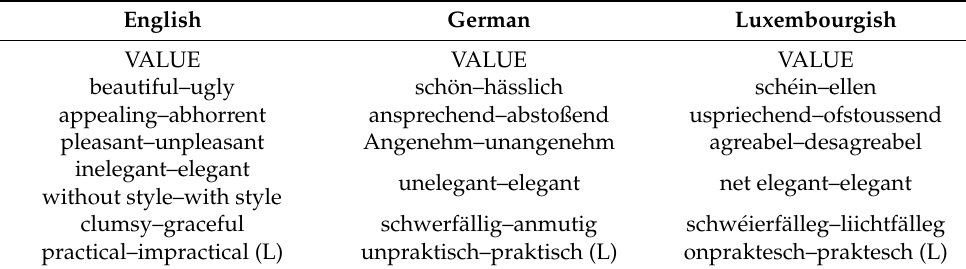
Table 1. Bipolar adjective pairs of the AtoL